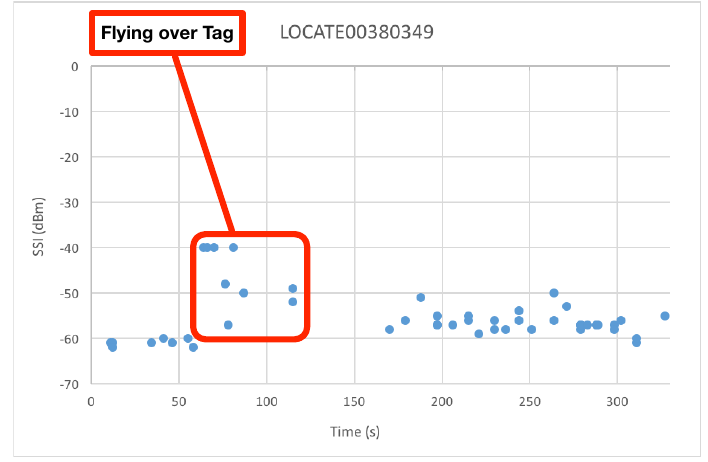
Figure 12. SSI evolution of a tag during an inventory